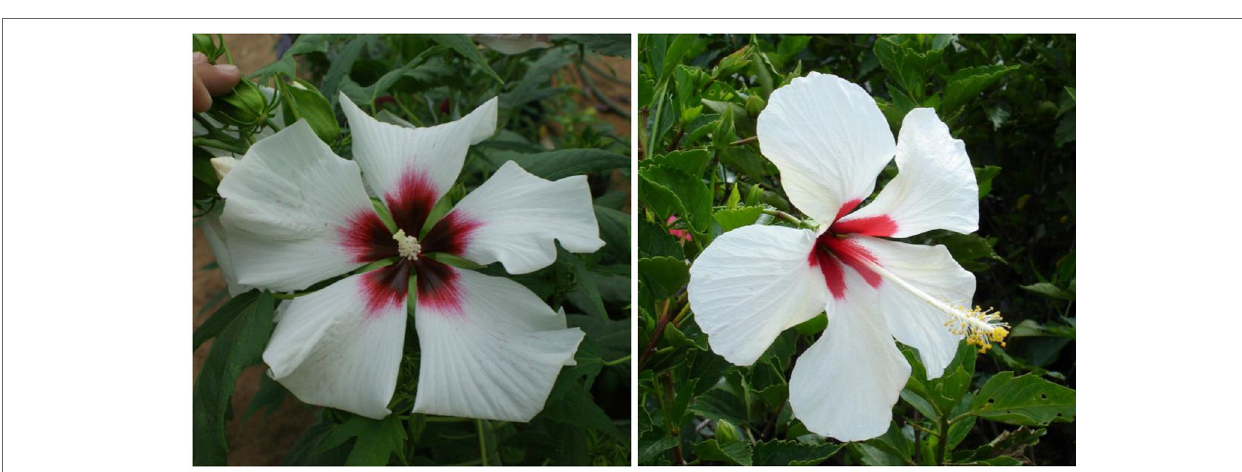
FIGURe 7 | Flower color and shape of H. x moscheutos hybrid “TAMUS-4621” (left) and H. rosa-sinensis “Hawaiian Dot” (right). Photo credits: Dariusz P. Malinowski (“TAMUS-4621”) and Georgi Stanev (“Hawaiian Dot”). Used with permission.